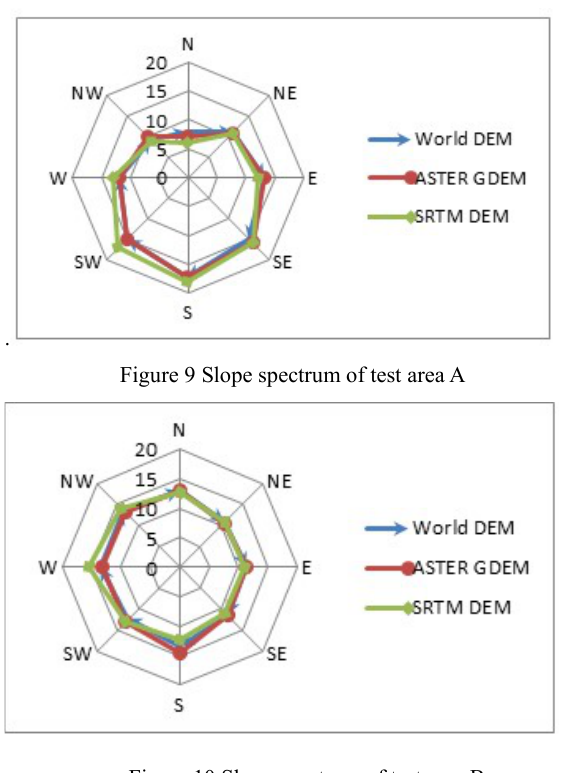
Figure 10 Slope spectrum of test area